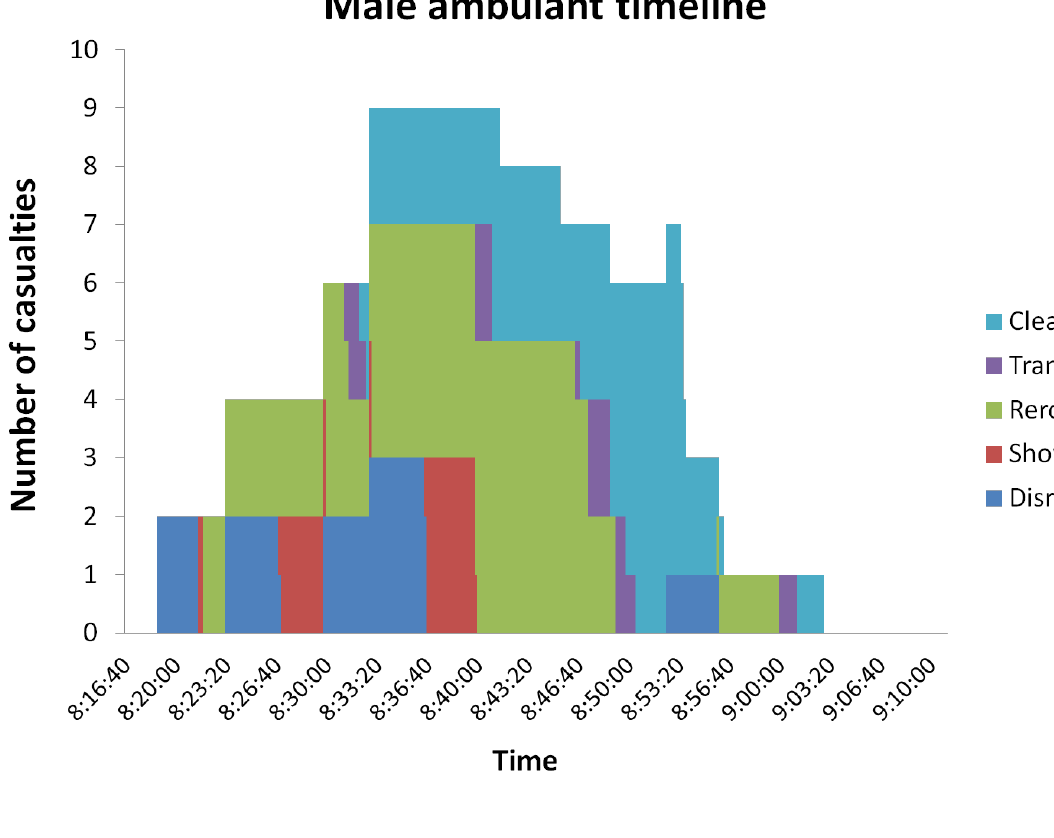
Figure A5. 11 male ambulant casualties passed through as described in the caption of Figure A4 but 1 of these casualties was untracked through the entire process. 1 group of 2 casualties and 1 group of 3 casualties were in the shower section for the full 3 minute duration. The re-robe section was at the intended capacity of 5 for approximately 6 minutes despite groups of less than 5 entering the MD1. The casualty clearing station never exceeded the intended capacity of 12 when combining both male and female casualties. The final male casualty to go through the system was a member of the film crew having re-entered the hot zone; this was also the case for the two final females in Figure